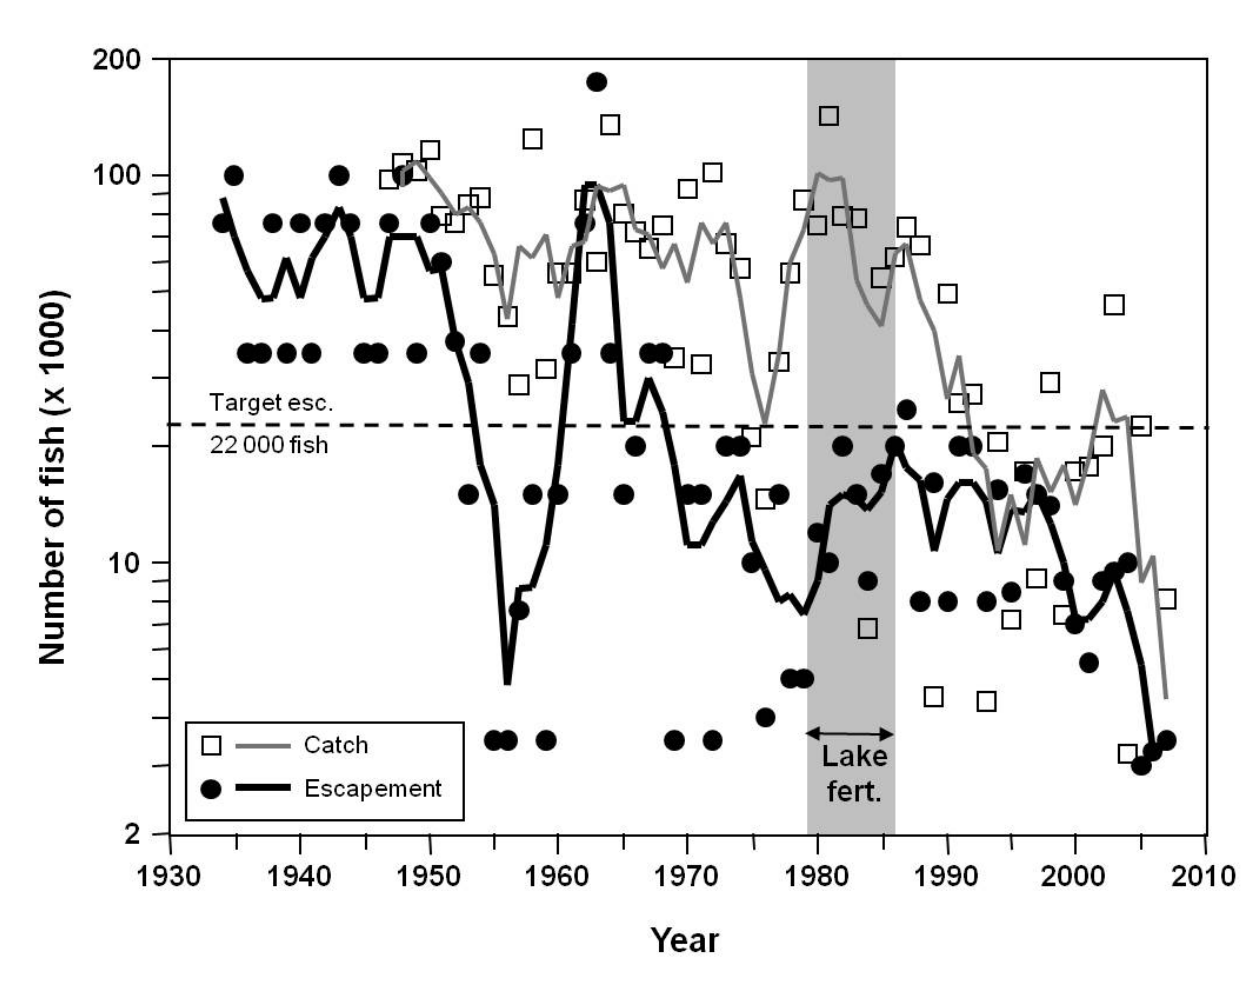
Fig. 2 . Estimated escapement of Kitlope River sockeye salmon (1934–2007) and commercial sockeye catch (seine + gillnet + troll) from coastal approach waters (Management Area 6; 1947–2007; DFO, unpublished data ). Lines represent 3-year running averages, the shaded area represents the period of artificial lake fertilization, and the dashed line represents the management target escapement. Note log10